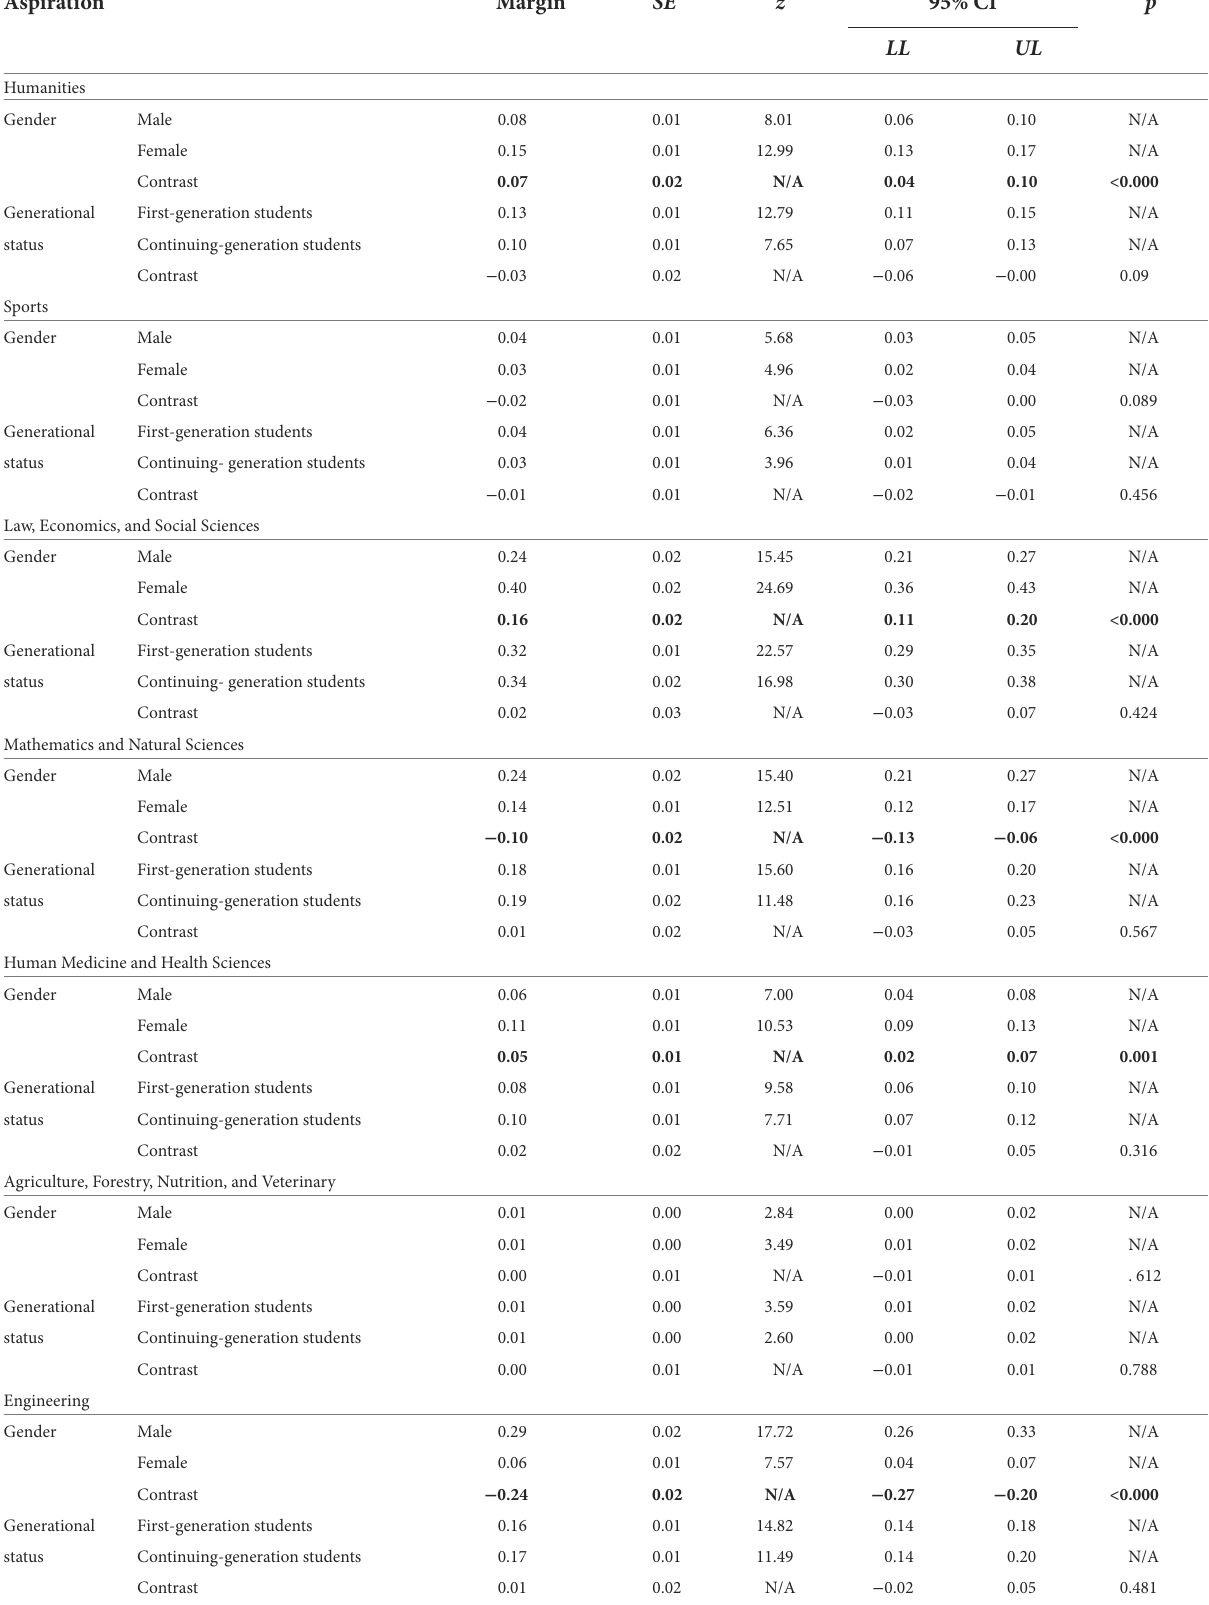
TABLE 2 Marginal means for study program aspiration predicted by gender and generational status (SES controlled). Aspiration